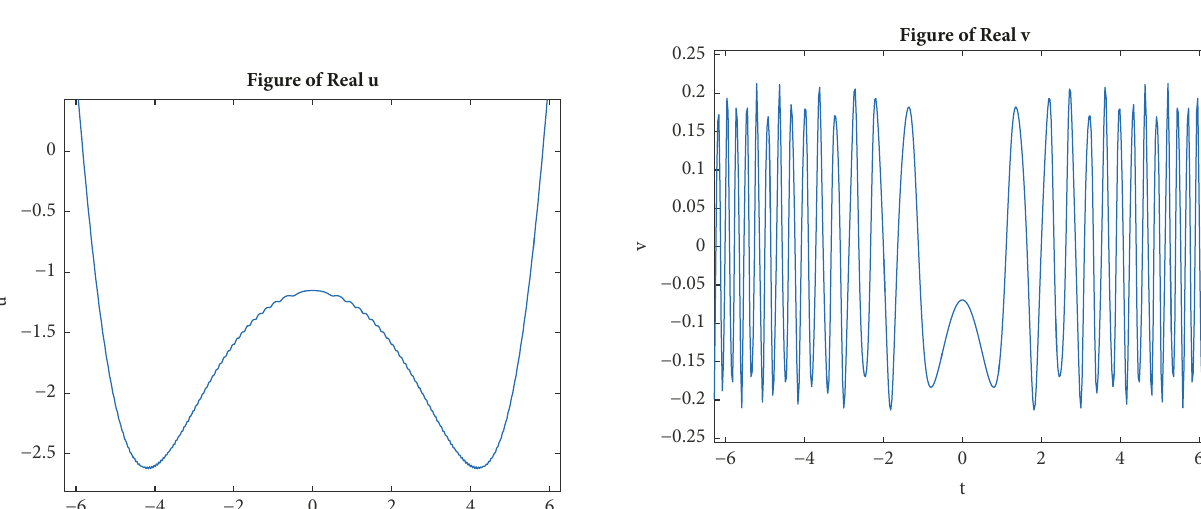
Figure 1: 𝑥 = 0.9 , 𝑙 1 = 0.3 , 𝑙 2 = 0.5 , 𝑙 3 = 0.8 , 𝑚 1 = 1 , 𝑚 2 = 2 , 𝑦 = 3 , and 𝑡 ∈ [−6,6] .